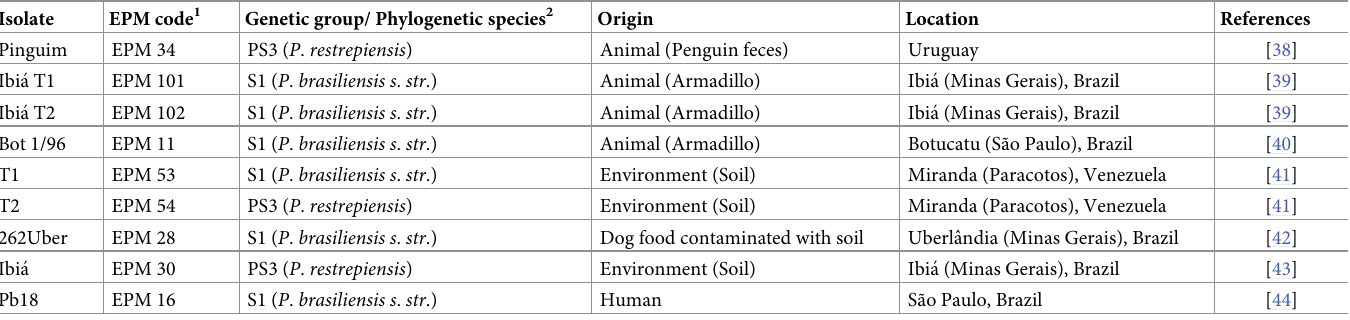
Table 1. Origin and location of P . brasiliensis complex isolates used in this study.